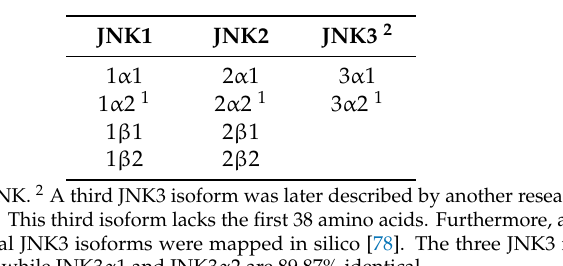
Table 1. c-Jun N-terminal kinase (JNK) isoforms described by Gupta et al.